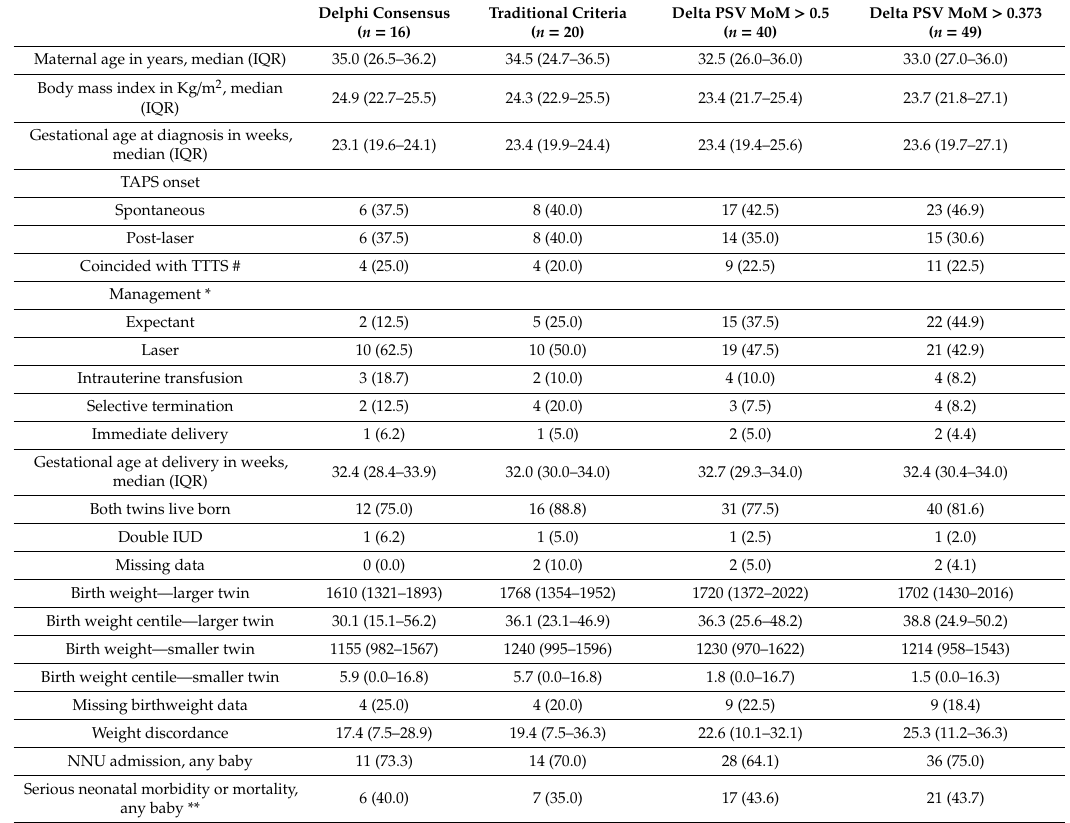
Figure 2. The outcomes of antenatal twin anemia polycythemia sequence (TAPS) cases according to various criteria. Cases diagnosed with Delphi consensus criteria had a higher incidence (87.0% vs. 59.0%) of progression or intervention compared to delta peak systolic velocity multiple of median > 0.373 group ( p = 0.037). Table 1. Characteristics and natural history of antenatal twin anemia polycythemia sequence (TAPS) cases diagnosed according to the different diagnostic criteria.